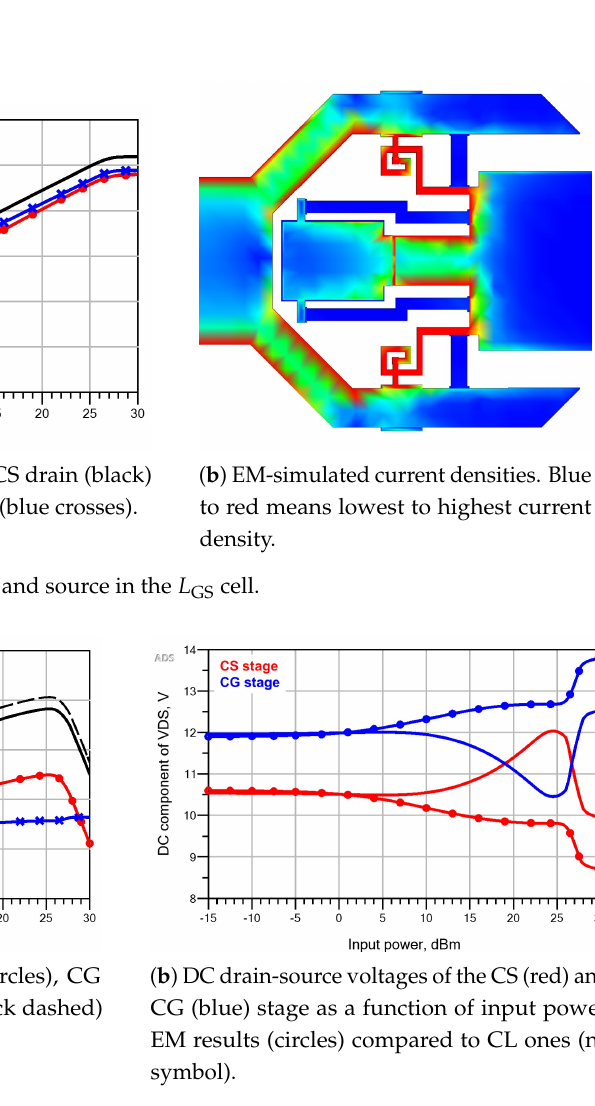
Figure 24. EM simulation results of the L GS